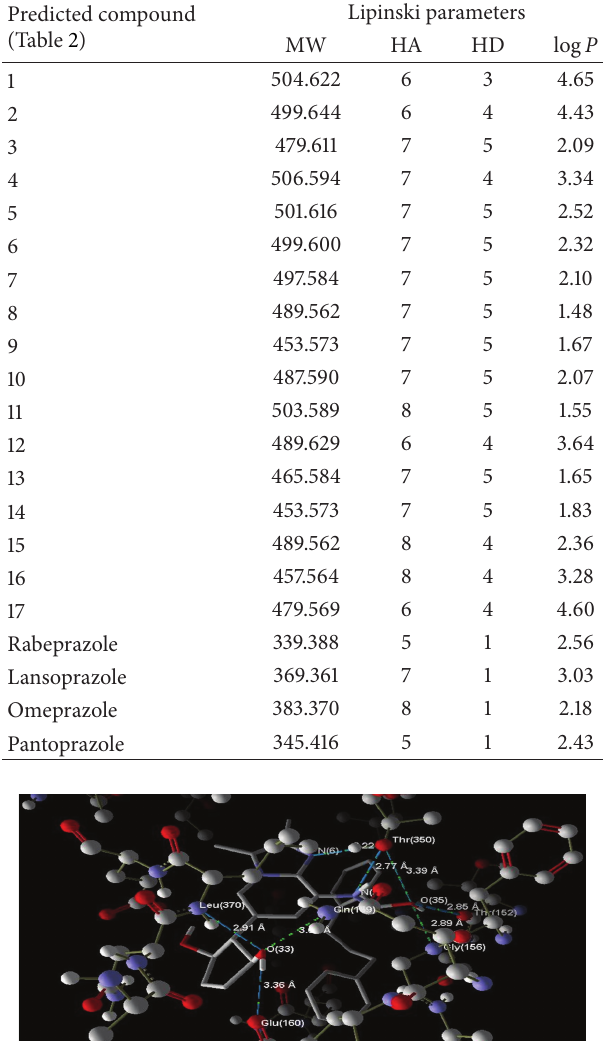
Table 4: Data related to Lipinski rules in comparison to those licensed.